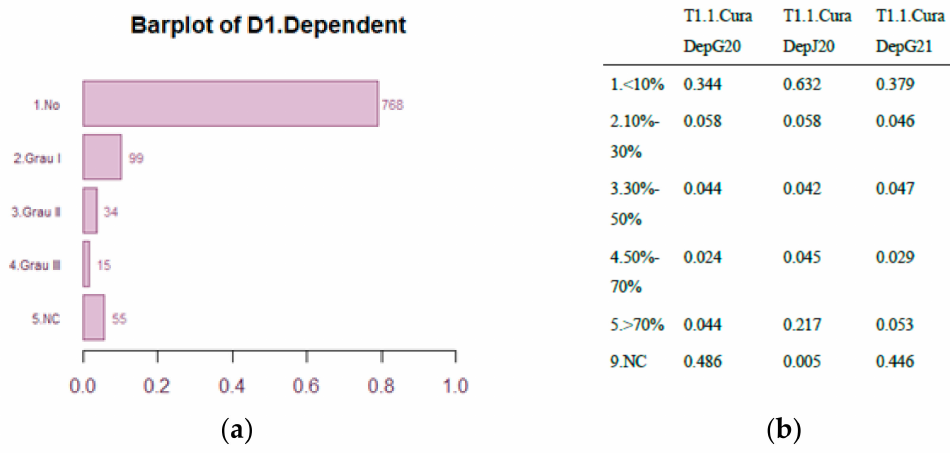
Figure 26. ( a ) Barplot of D1.Dependent. ( b ) Cross table of T1.1 per